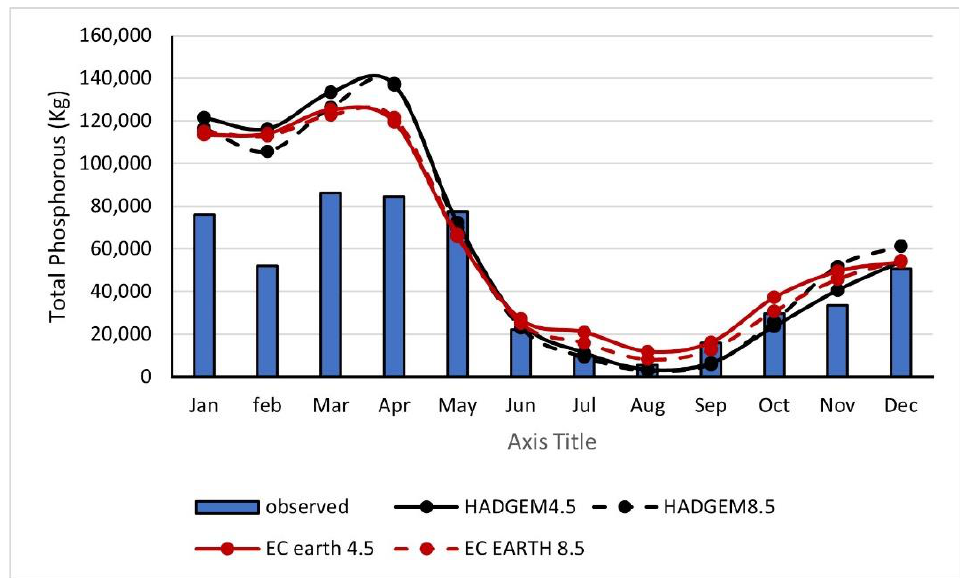
Figure 9 . Average monthly total phosphorous (TP) load for climate scenarios RCP 4.5 and RCP 8.5 of GCM climate models HadGEM2 and EC-Earth .